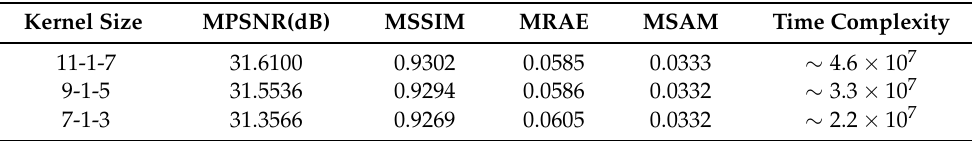
Table 5. Performance and time complexity of using different kernel sizes in Resblock (the metric is the average of all test images).